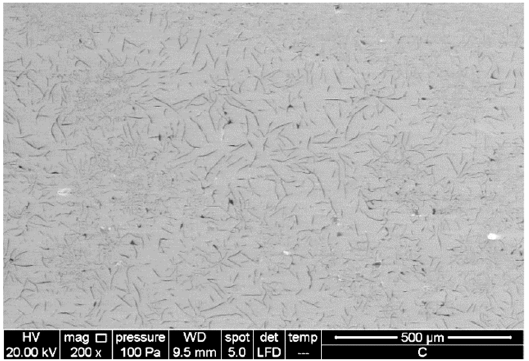
Figure 1. Microstructure of grey cast iron microstructure in the unetched state.